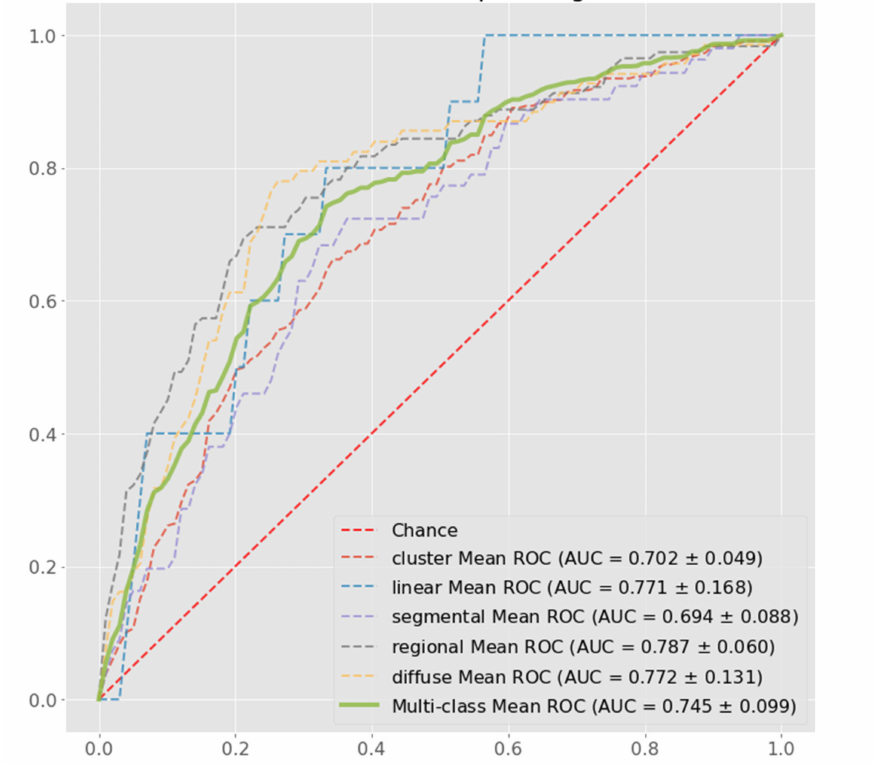
Figure 4. Multi-class receiver operating characteristic curves for distribution classification.